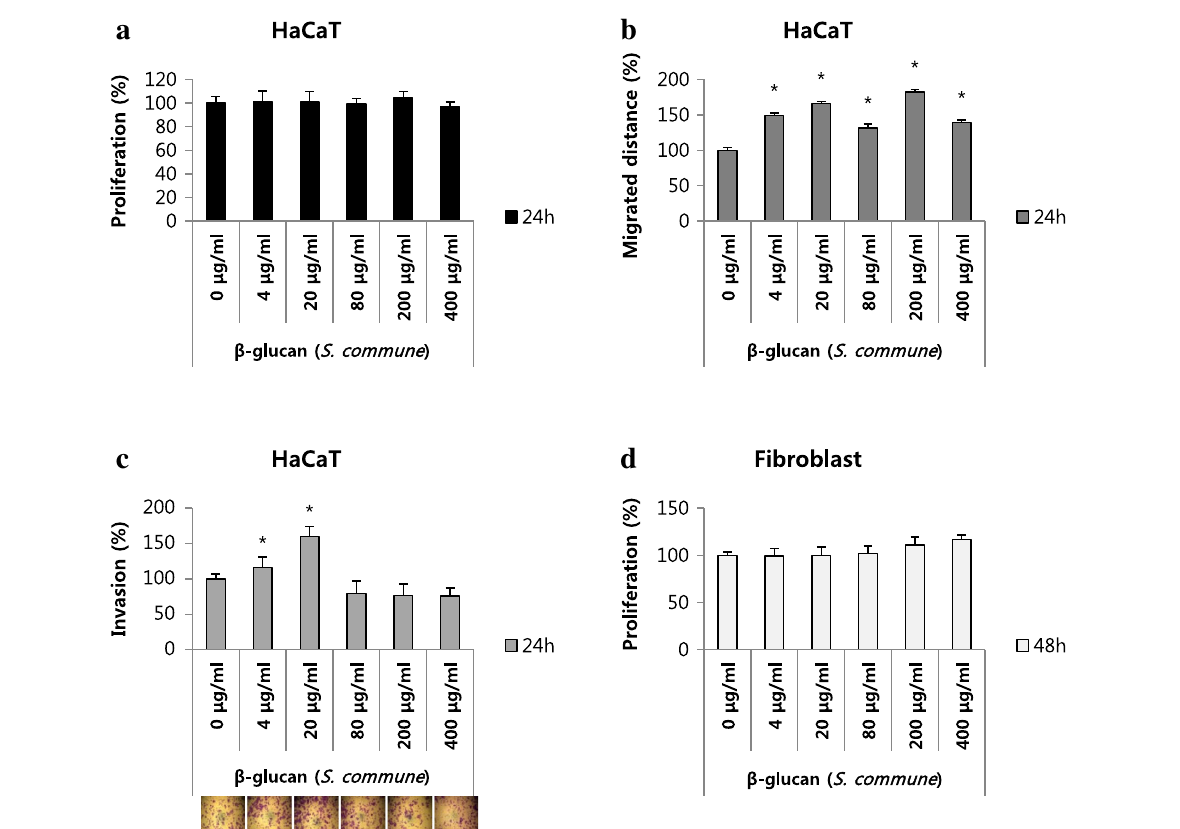
Fig. 3 The stimulation effect of beta-glucan derived from S. commune on keratinocyte migration. a Viability of HaCaT and d fibroblast treated with beta-glucans derived from S. commune (0–400 μg/ml). The cells (2 10 4 cells/ml) were seeded and treated with 0–40 μg/ml for 24 h. Viability of × cells was measured using the MTT solution (5 mg/ml). b Scratch wound healing assay with HaCaT treated as described in a after 24 h. HaCaT cells (7 10 4 cells/well) were seeded on a 48 well plate and a scratch was made on the cell monolayer by drawing a pipette tip across the well. Migration × distance was measured using the ImageJ program. *P < 0.05 as compared to the control. c Transwell invasion assay with HaCaT cells treated with beta-glucans derived from S. commune . Invasive ability was measured by fixing with 4% of formaldehyde and staining with a 1% crystal violet solution. The photographs were acquired at 4 magnification using a microscope. *P < 0.05 as compared to the ×